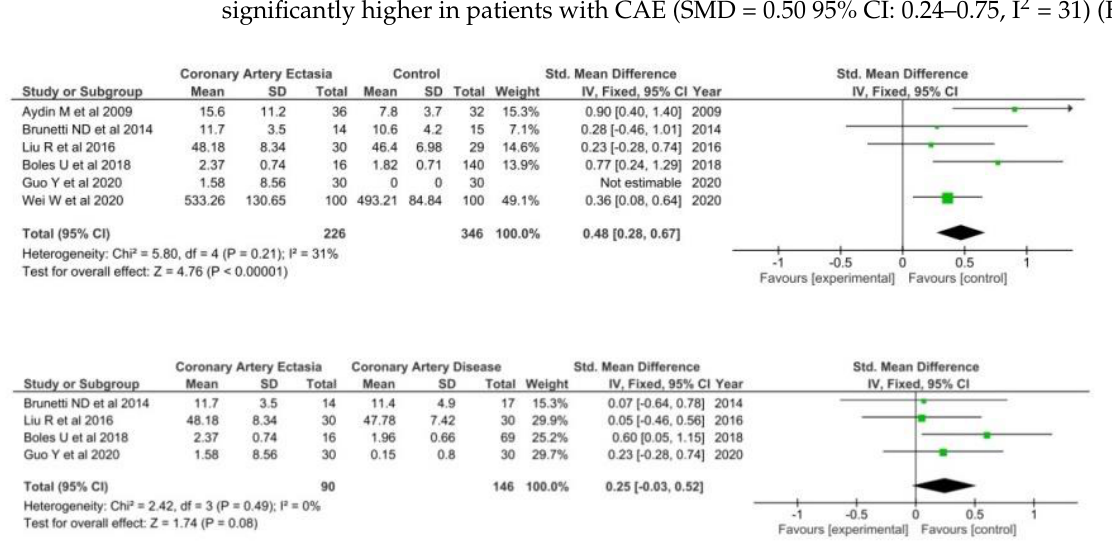
Figure 5. TNF-a in CAE patients versus controls (top) and CAE versus CAD patients (bottom).